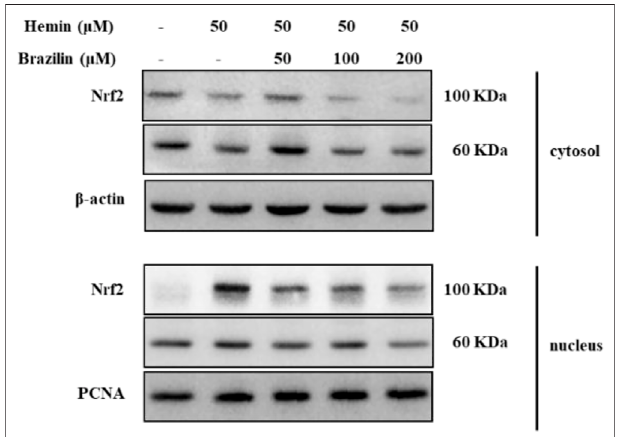
FIGURE 4 | Blockage effects brazilin on hemin-mediated Nrf2 translocation into nuclear fraction. Cells were treated with indicated dosages of brazilin in the presence of hemin. After 4 h incubation, fraction extracts of nuclearandcytoplasmwereprepared.Nrf2moleculeswereidenti fi edby Westernblotting.PCNAand β -actinwereusedasloadingcontrolsfornuclear- and cytosol-speci fi c marker protein, respectively. The experiments were repeated for at least of three times.